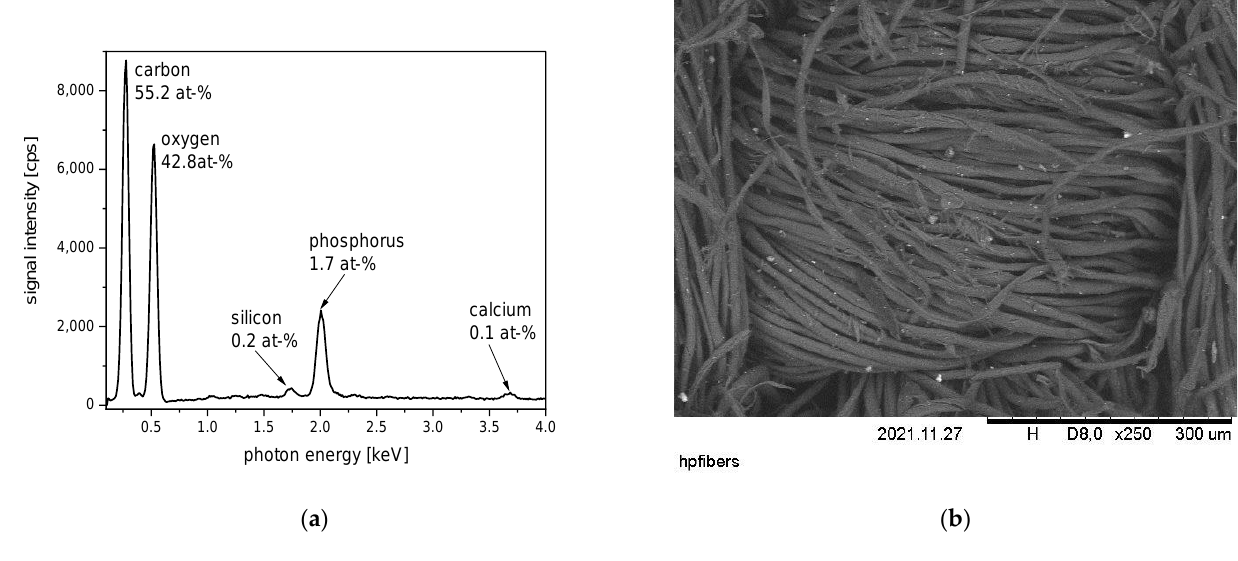
Figure 25. Commercially available cotton fabric with flame-retardant finishing — ( a ) EDS spectrum; ( b ) SEM image.